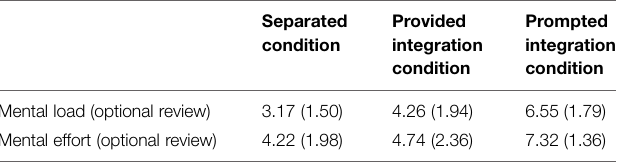
TABLE 2 | Mean (and SD) of mental load and mental effort while working on the optional review (and on the prompts for the promoted integration condition respectively) in the three experimental